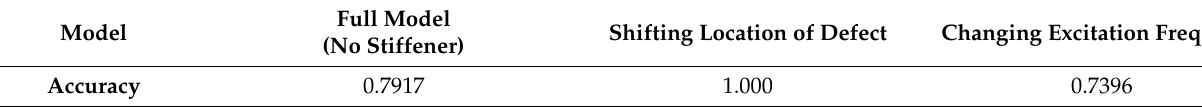
Table 11. Ablation test result.